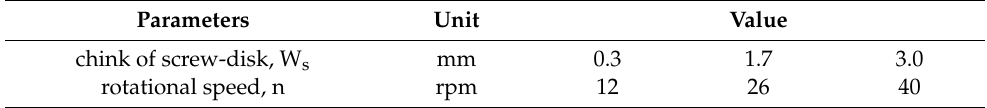
Table 2. Methodology of WPCs’ assessment.